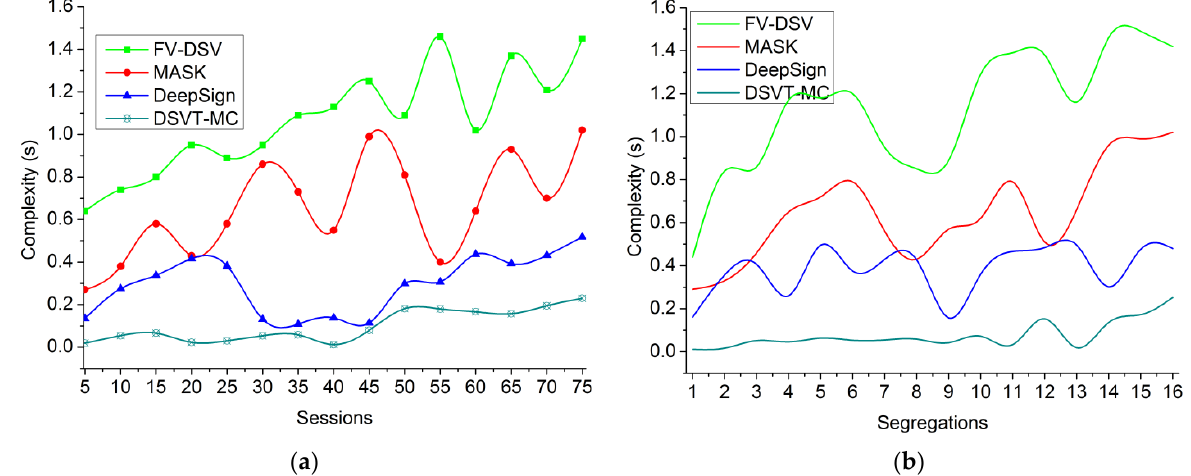
Figure 13. Complexity Analysis for ( a ) Different Session ( b ) Segregation.